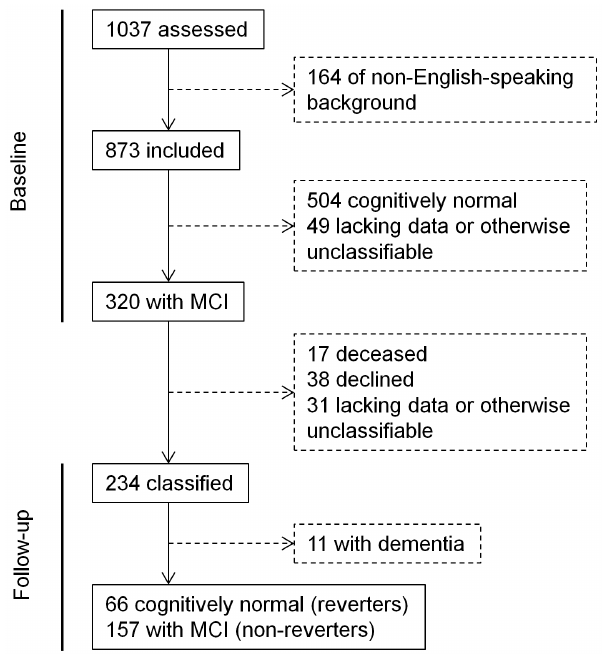
Figure 1. Flow diagram of sample selection.